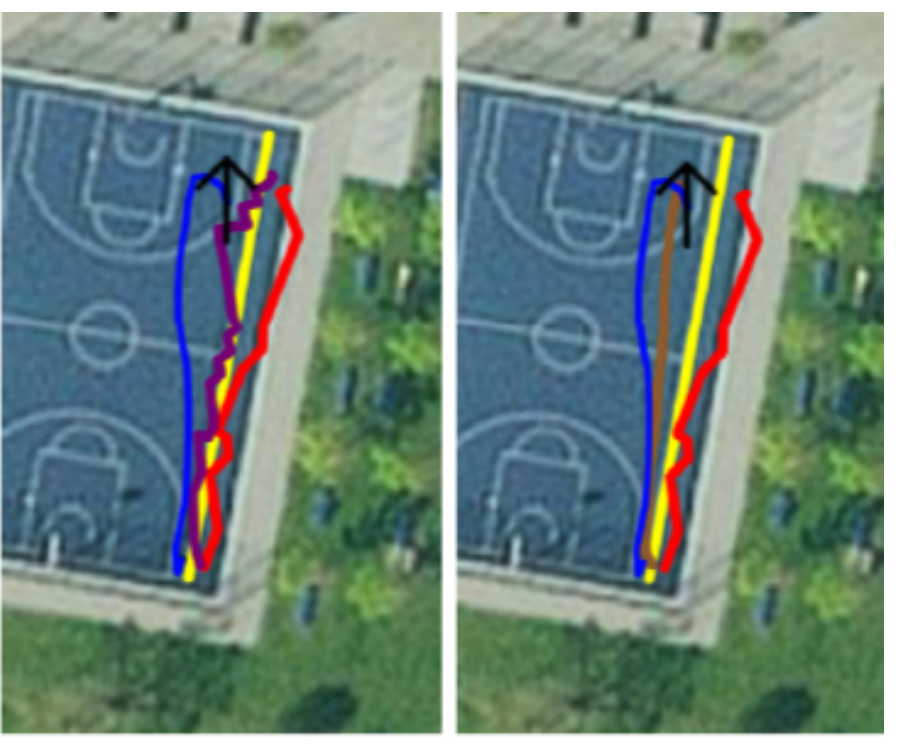
Figure 15. Jittering signal of KF Vel CT ( purple ) and smooth signal of KF CT ( brown